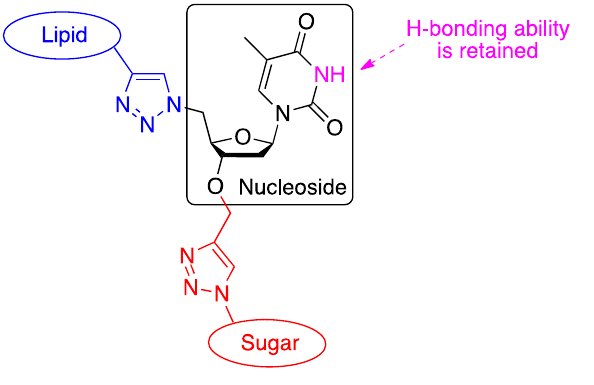
Figure 3. Schematic representation of 2nd generation GNL